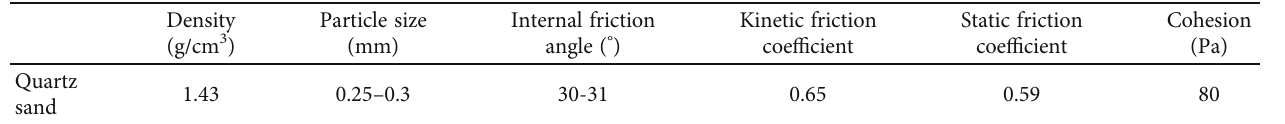
Table 2: Material parameters of physical simulation experiments.